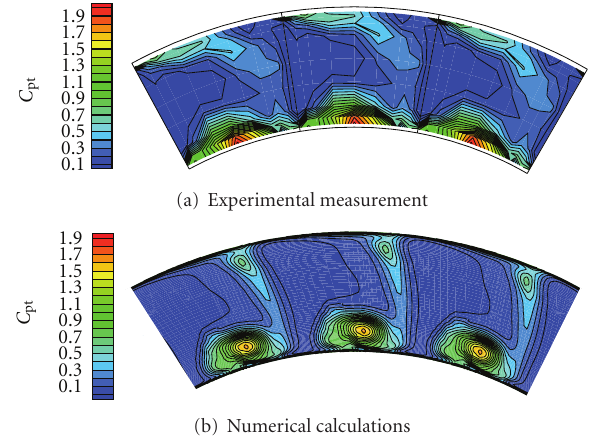
Figure 10: Downstream total pressure coe ffi cient.